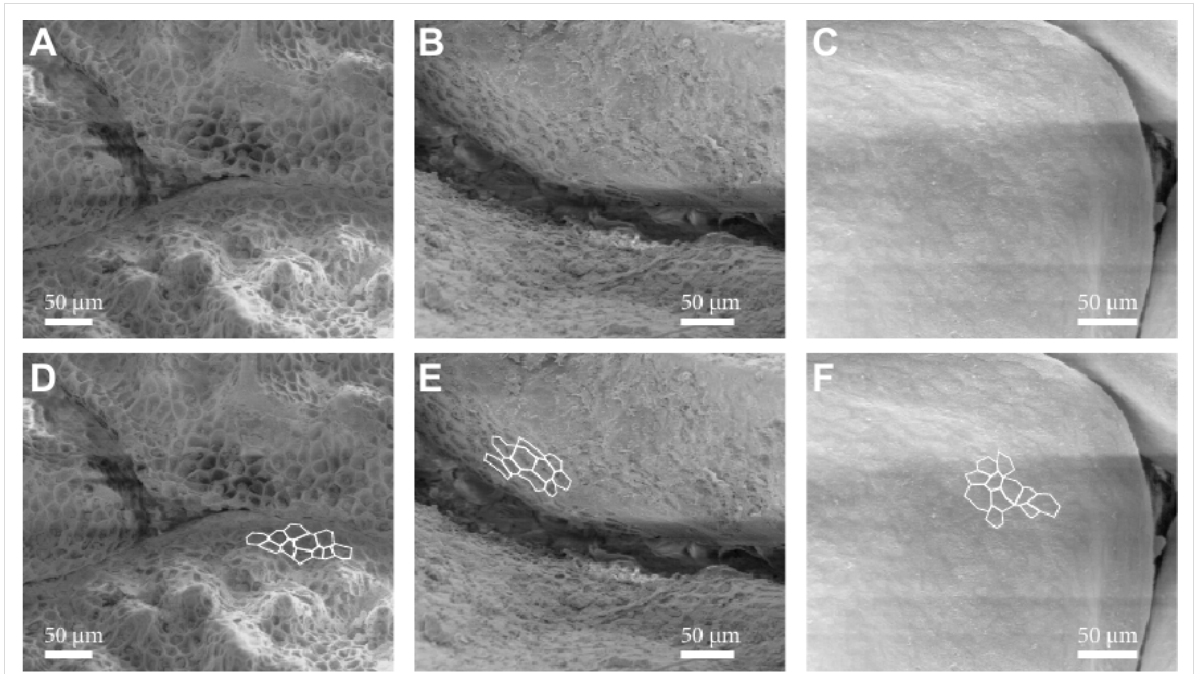
Figure 5: Micro ornamentation of the scales of the three investigated lizard species. (A) Moloch horridus shows the honeycomb like micro ornamenta- tion virtually all over all scales. (B) Phrynosoma cornutum shows clear honeycomb like micro structures, but typically mainly at the periphery of the scales. (C) Phrynocephalus arabicus the only honeycomb like structures appear like dimples. (D) (E) and (F) show the images of A–C with some of the micro ornamentations marked for better orientation.